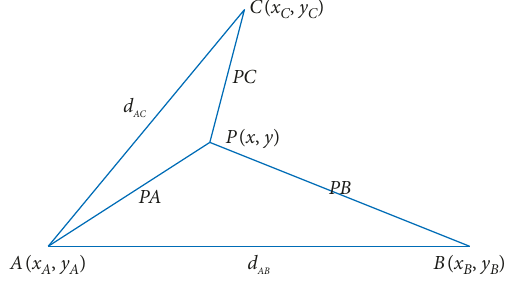
Figure 14: Position of 3 receiving points and 1 target point.